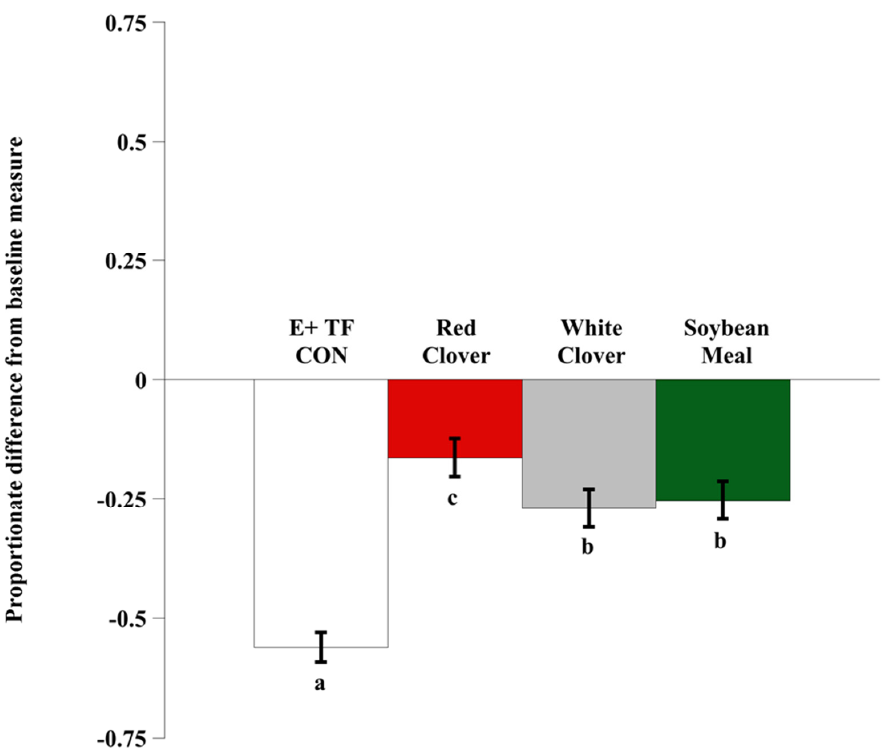
Figure 1. Ultrasonic measures of proportionate differences from baseline measures for luminal area of the carotid artery in rumen-fistulated wether goats that were infused with toxic E+ TF seed ± red clover, white clover, or soybean meal. Baseline measures were taken with goats receiving ad libitum chopped orchardgrass ( Dactylis glomerata )—timothy ( Phleum pratense ) hay with no rumen infusion treatments. Images for determining baseline measures were collected on the last 2-d of the adaptation period. Means lacking a common letter (a,b,c) are different. Treatment: p < 0.0001; period: p = 0.2415; block: p = 0.3030; period × treatment: p = 0.8491; Pooled SEM: Treatment = 0.0313; period = 0.0354; block = 0.0532; period × treatment =